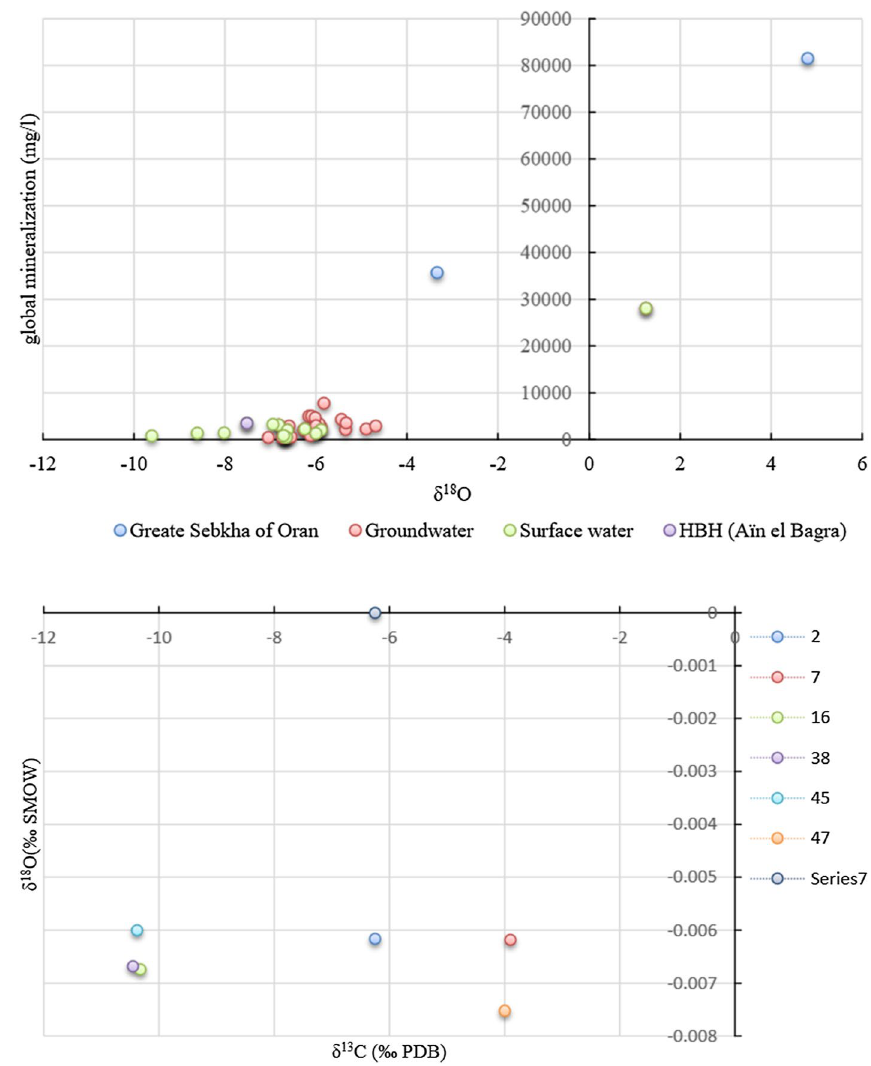
Fig. 4 Relation 18 O -Global mineralization